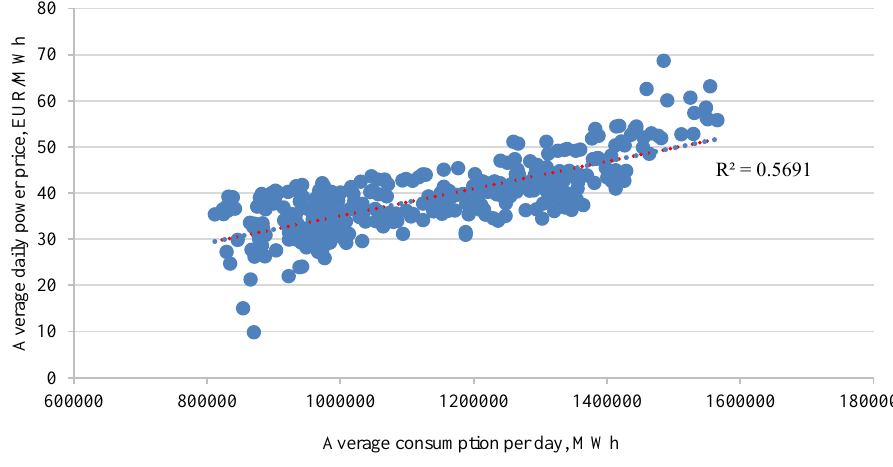
Fig. 6. Correlation between power market price and daily power consumption during 2019 (Data source: Nord Pool Spot, 2020).